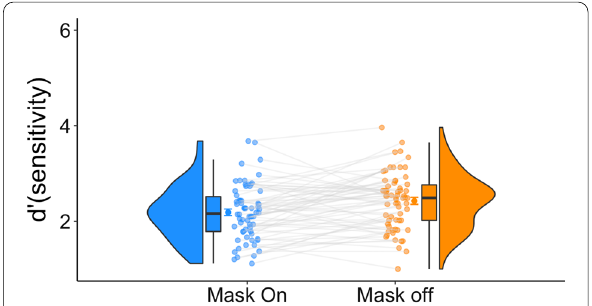
Fig. 3 Experiment 2 results. Better accuracy results were observed for the mask-off condition. For each condition, we present the distribution, the individual data points, and the quartiles of the dataset. The whiskers depict the rest of the distribution excluding outliers. The darker dots denote the means, and the error bars denote one standard